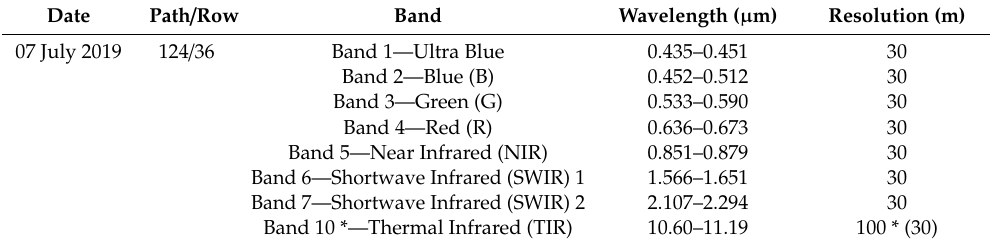
Table 1. Characteristics of the Landsat-8 OLI image used in this study.